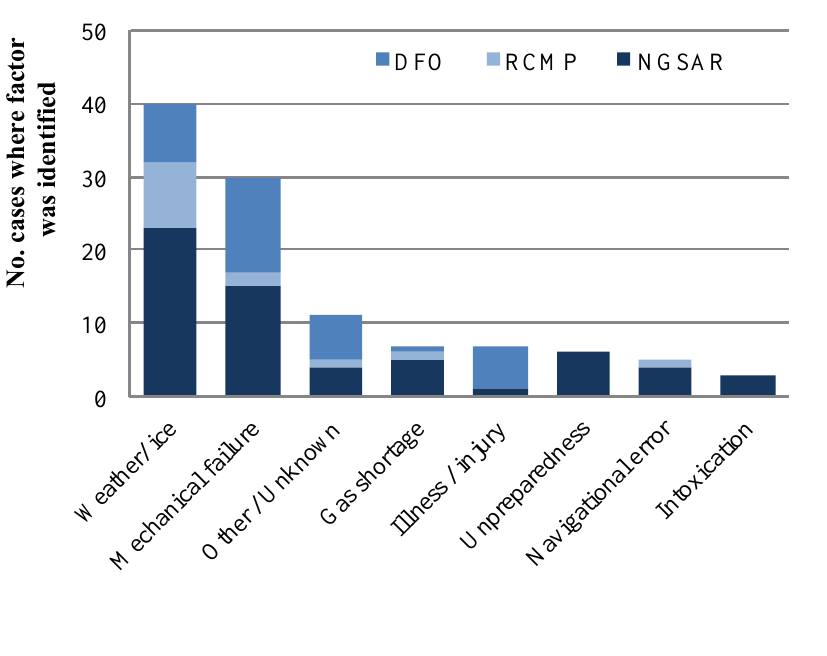
Figure 4. Contributing factors for Nain SAR cases from 1995 to